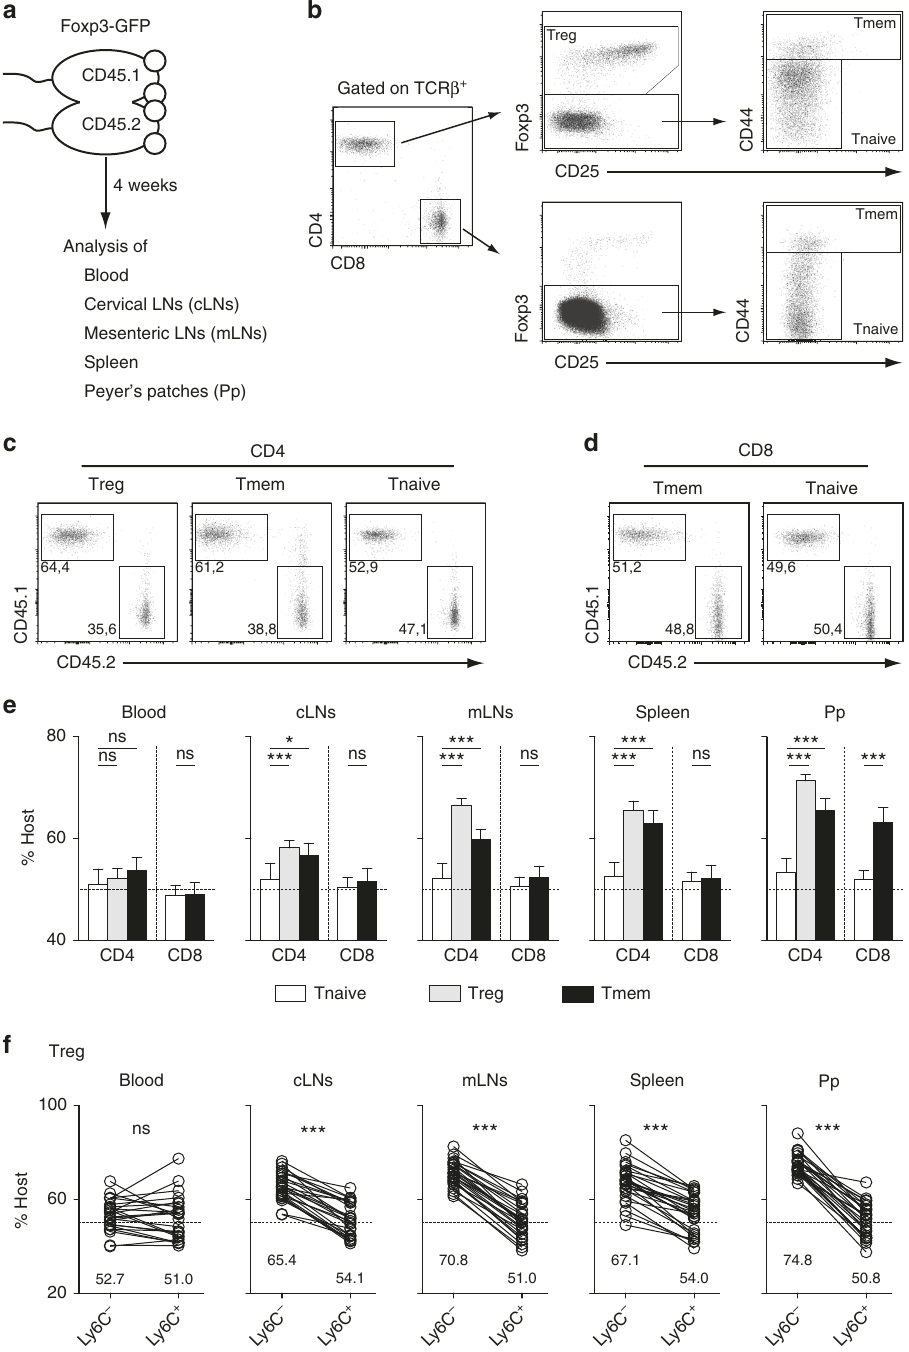
Fig. 1 Analysis of mouse parabionts reveals the long-term residence of T cell populations in SLOs. Four weeks after parabiosis surgery, blood, cervical LNs (cLNs), mesenteric LNs (mLNs), spleen, and Peyer ’ s patches (Pp) were recovered and analyzed. a Diagram illustrating the experimental model. b Gating strategy to de fi ne naïve (Tnaive), memory (Tmem) and regulatory (Treg) CD4 and CD8 T cells. c CD45.1/CD45.2 dot-plots are shown for mLN CD4 Treg, Tmem and Tnaive cells from a representative CD45.1 parabiont. d CD45.1/CD45.2 dot-plots are shown for mLN CD8 Tmem and Tnaive cells from a representative CD45.1 parabiont. e Proportions of host cells (CD45.1 + for the CD45.1 parabiont and CD45.2 + for the CD45.2 parabiont) among the indicated CD4 T cell and CD8 T cell subsets recovered from blood, cLNs, mLNs, Spleen, and Pp are shown for at least ten parabiotic pairs from three independent experiments (mean ± SEM; paired t -test). f Proportions of host cells among Ly-6C − and Ly-6C + CD4 Treg cells. Each pair of dots represents an individual mouse (paired t -test). * p < 0.05, *** p < 0.001. ns not signi fi